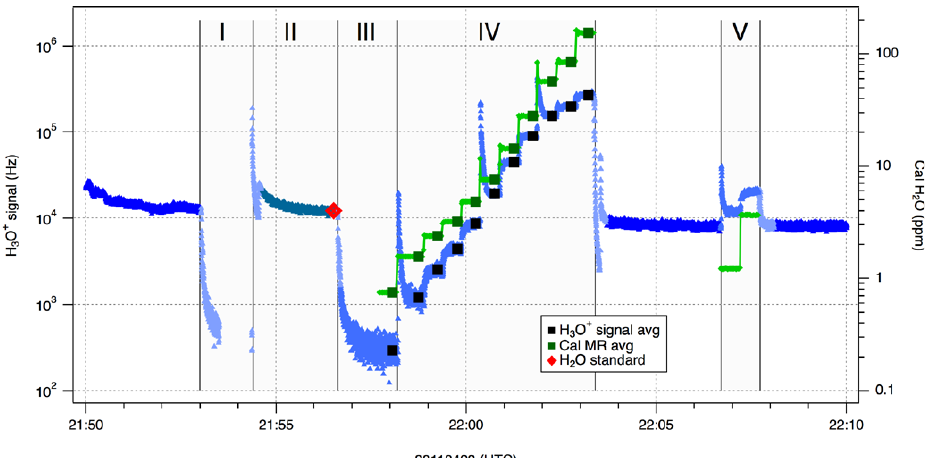
Fig. 9. In-flight calibration sequence from the flight on 23 April 2011. The small blue symbols are the H 3 O + signal and the green trace is the H 2 -generated H 2 O calibration mixing ratio. The enumerated shaded regions in the plot denote zero air and calibration gas flow to the inlet. Regions I and III are zero air alone, region II is the H 2 O standard, region IV is zero air plus H 2 /Pt-H 2 O calibration flow, and region V is the H 2 /Pt-H 2 O standard addition to ambient air. The spikes that appear in three of the calibration steps in region IV are caused by a burst in the H 2 flow when the 3-way solenoid valves switch the calibration flows from the higher pressure in the dump line to the catalyst. The signal from the bursts decays rapidly ( τ < 2s) and does not affect the average value calculated during the last 10s of the calibration step. The red diamond denotes the average H 3 O + signal during the last 10s of the H 2 O standard, the black squares are the average H 3 O + signal during the last 10s of each H 2 /Pt-H 2 O calibration step, and the green squares are the calculated absolute H 2 O mixing ratios for the last 10s of each calibration step. The mass scan performed during the calibration resulted in the apparent data gap in region I.